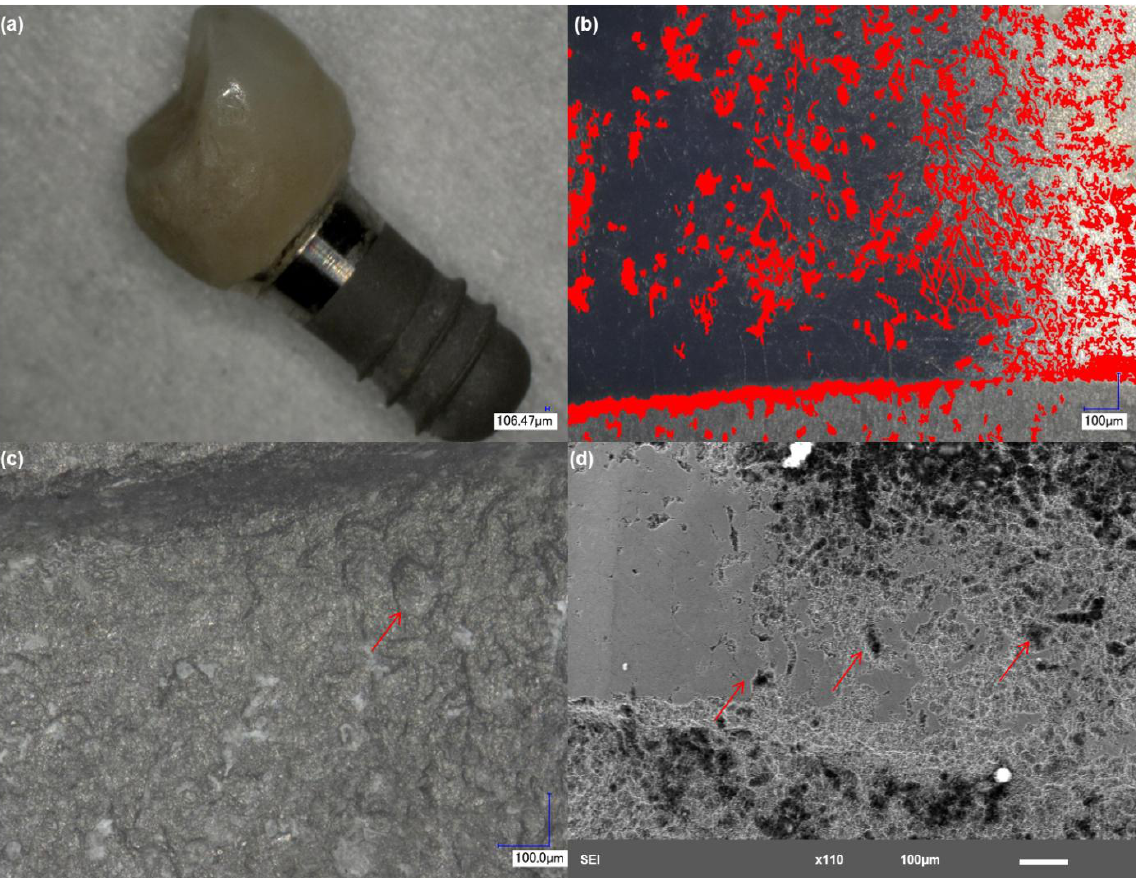
Figure 2. Structure of implant 1. ( a ) Low magnification showing overall features of the implant; ( b ) the smooth interfaces of the abutment showed a severe degree of pitting attack and scratching. The red areas highlight the pits present on the surface; ( c ) implant rough interface demonstrating pitting attack and deformities; and ( d ) higher magnification of an area with pitting attack and delamination of the top